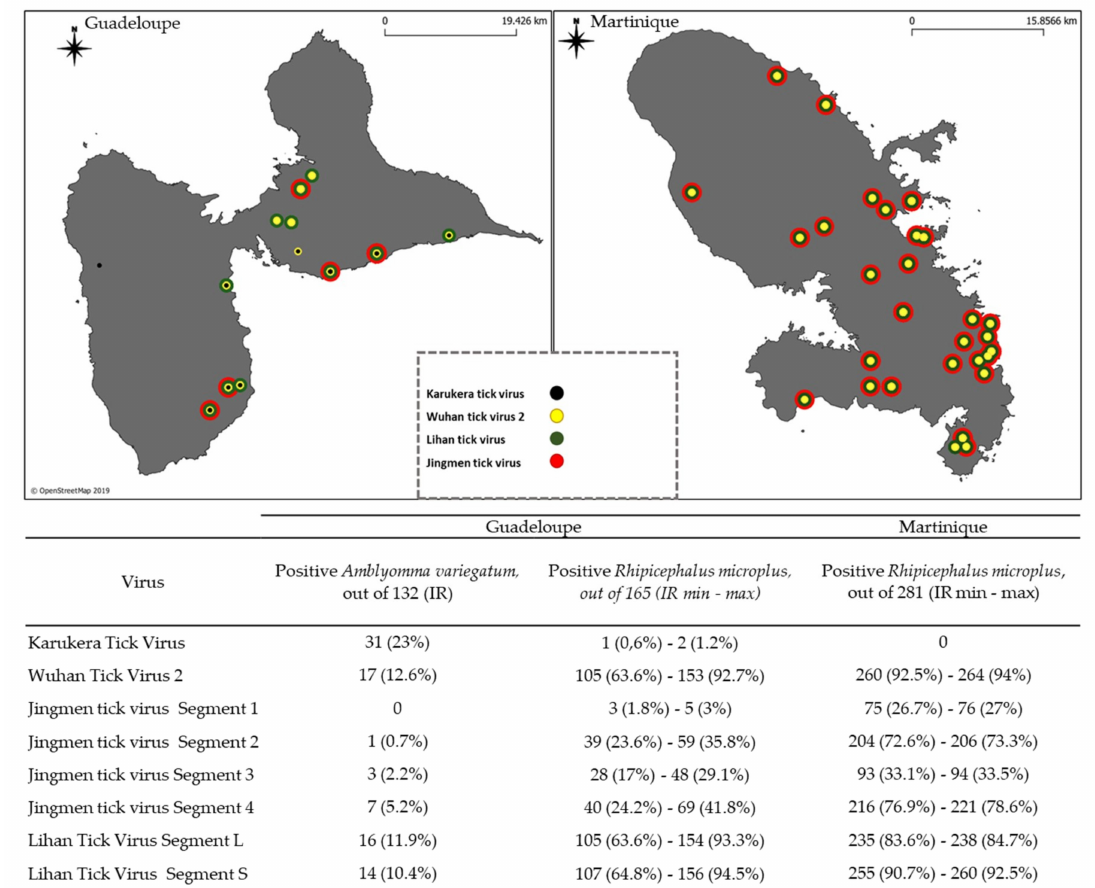
Figure 4. Virus Infection rates in ticks collected in Guadeloupe and Martinique. Number of positive ticks Amblyomma variegatum (out of the 132), Rhipicephalus microplus from Guadeloupe (out of 165) and Martinique (out of 281). As some samples of Rhipicephalus microplus were pooled, we present minimum and maximum infection rates of infected ticks. The maps of Guadeloupe and Martinique represent the ticks’s collection sites found positive for the Karukera tick virus, Wuhan tick virus 2, Jingmen tick virus and Lihan tick